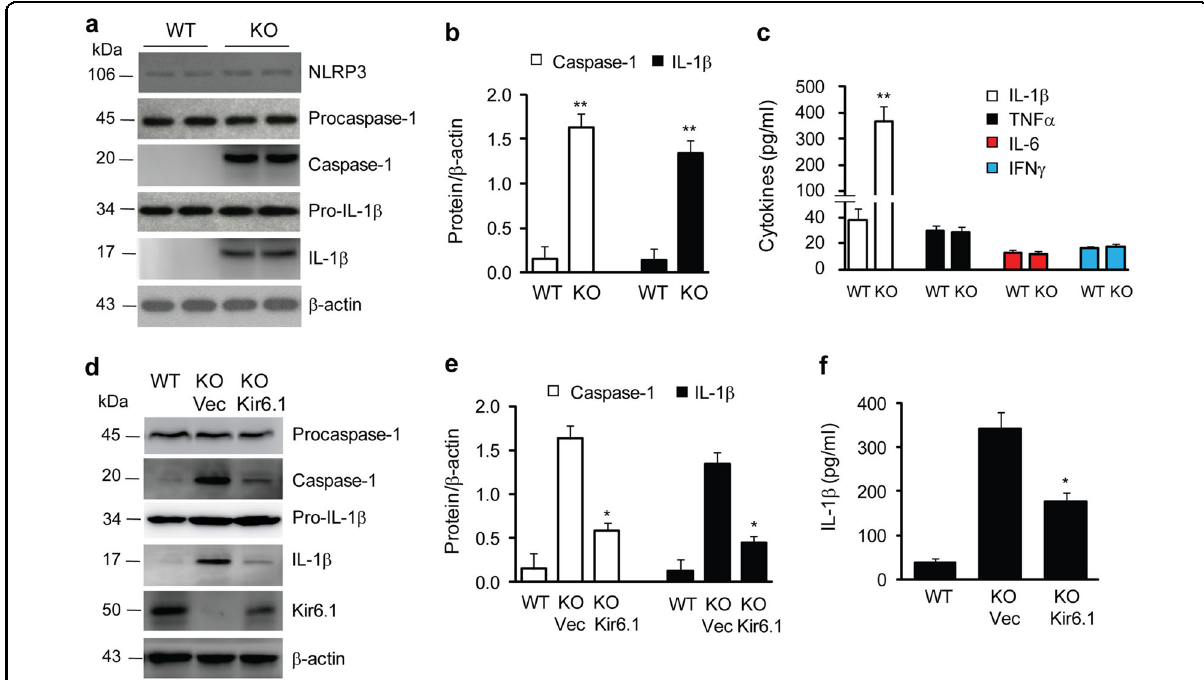
Fig. 1 Kir6.1 deletion activates the NLRP3 in fl ammasome in the liver. a Representative immunoblots showing NLRP3 in fl ammasome activation in the liver of Kir6.1 KO mice. WT and KO are Kir6.1 + / + and Kir6.1 − / − mice, respectively. b Quanti fi cation of caspase-1 and IL-1 β as shown in ( a ) ( n = 6). c Serum IL-1 β , TNF- α , IL-6, and INF- γ levels in WT and Kir6.1 KO mice as measured by ELISA ( n = 12). The data shown are the mean ± SEM. ** p < 0.01 vs WT. d Representative immunoblots showing the reduction in NLRP3 in fl ammasome activation in the liver of Kir6.1 KO mice by lentiviral expression of Kir6.1 for 7 days. e Quanti fi cation of data shown in ( d ) ( n = 4). f Lentiviral expression of Kir6.1 reduced serum IL-1 β ( n = 6). The data shown are the mean ± SEM. * p < 0.05 vs KO mice injected with the parent vector